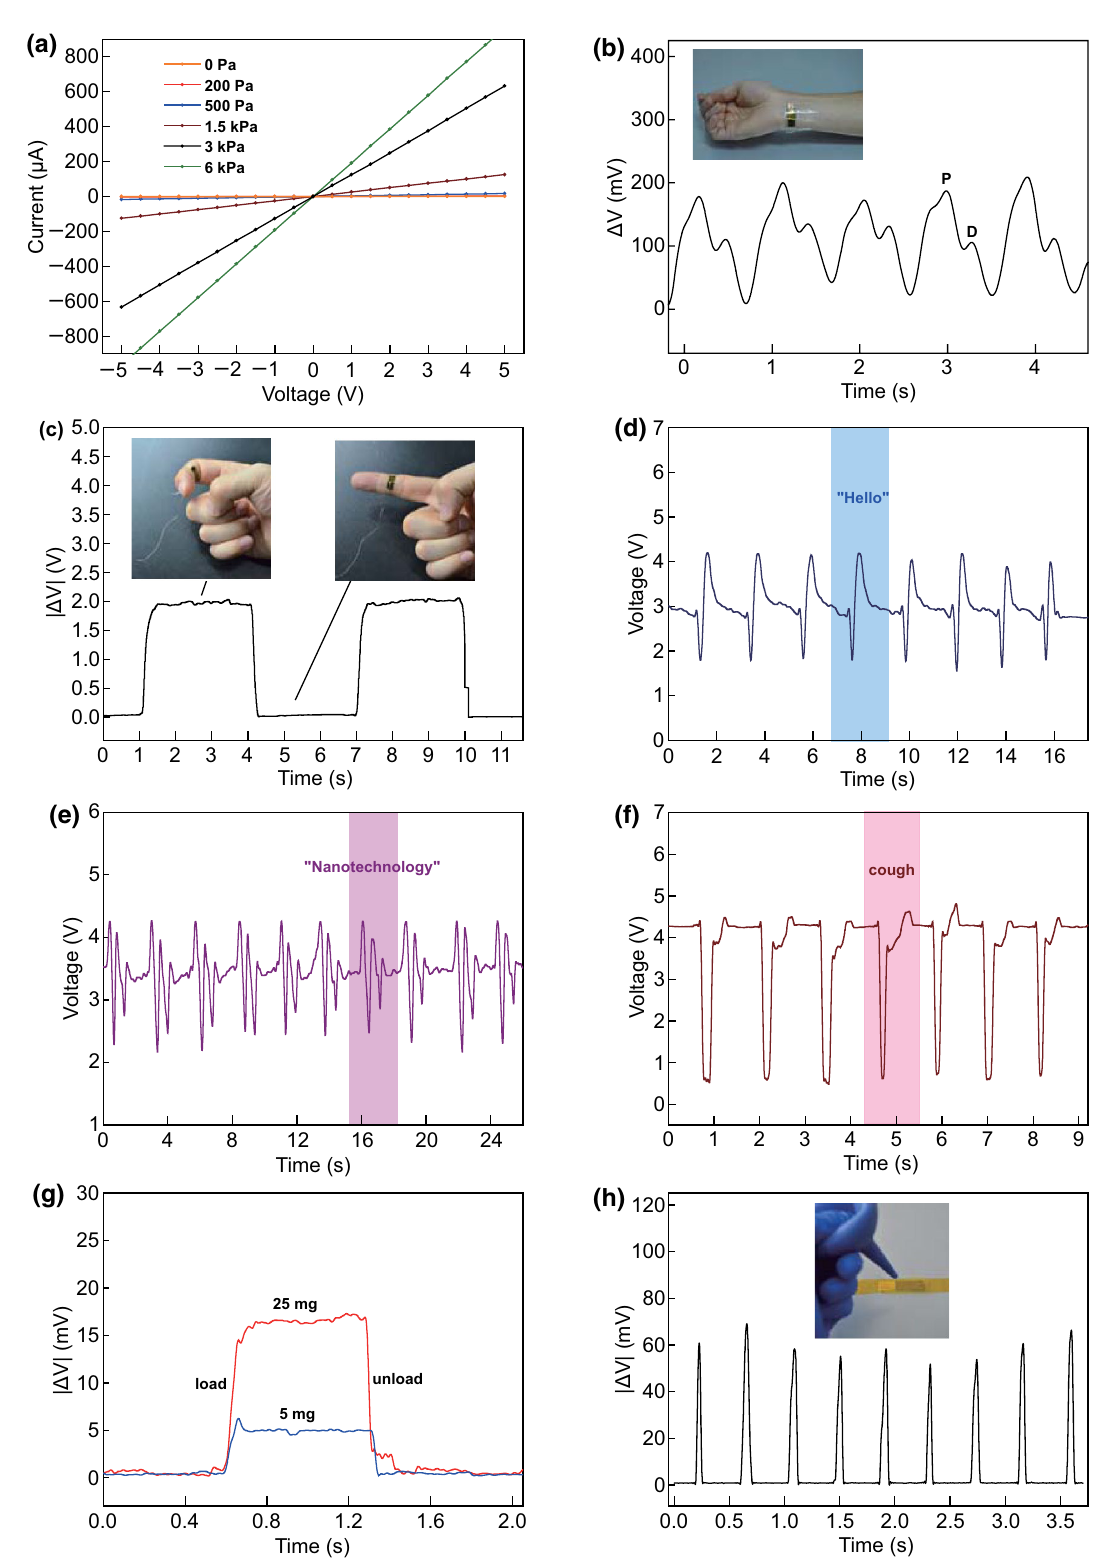
Fig. 3 a Current–voltage curves of the sensor from − 5 to 5 V under various pressures. b Detection of human wrist pulses. c Monitoring human finger bending. d – f Detection of different speech pronunciation and cough vibration. g Detection of micro-pressure of 25 mg and 5 mg. h Detection of local weak